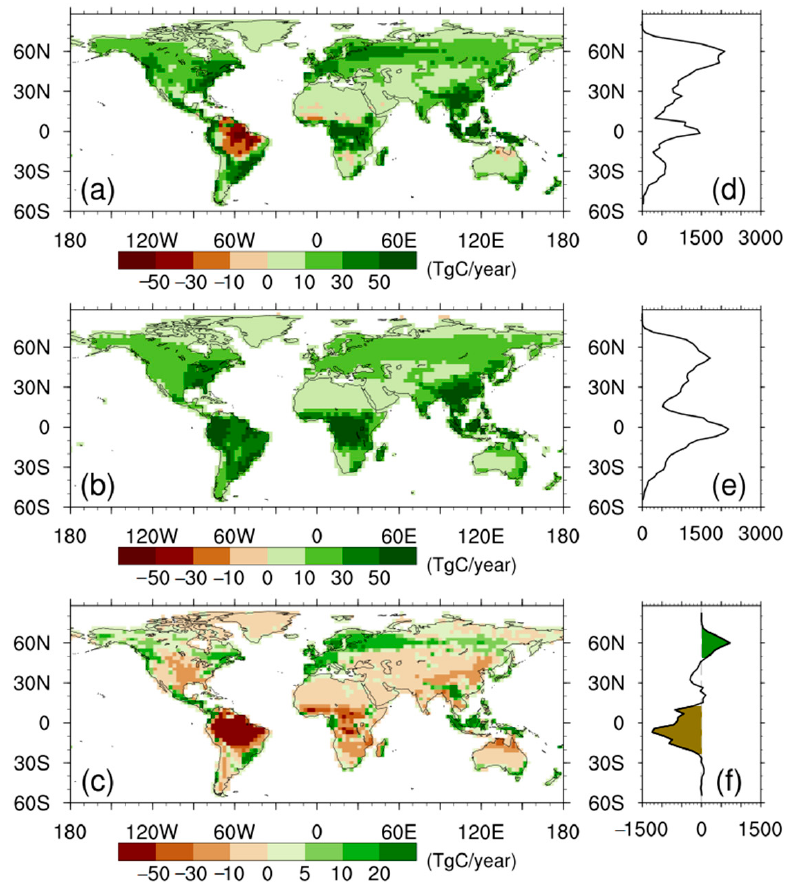
Figure 4. Spatial distribution of NPP anomalies for ( a ) the CAS-ESM2, ( b ) multi-model ensemble, and ( c ) the differences. ( d – f ) correspond to the zonal averages. All units are TgC year − 1 .